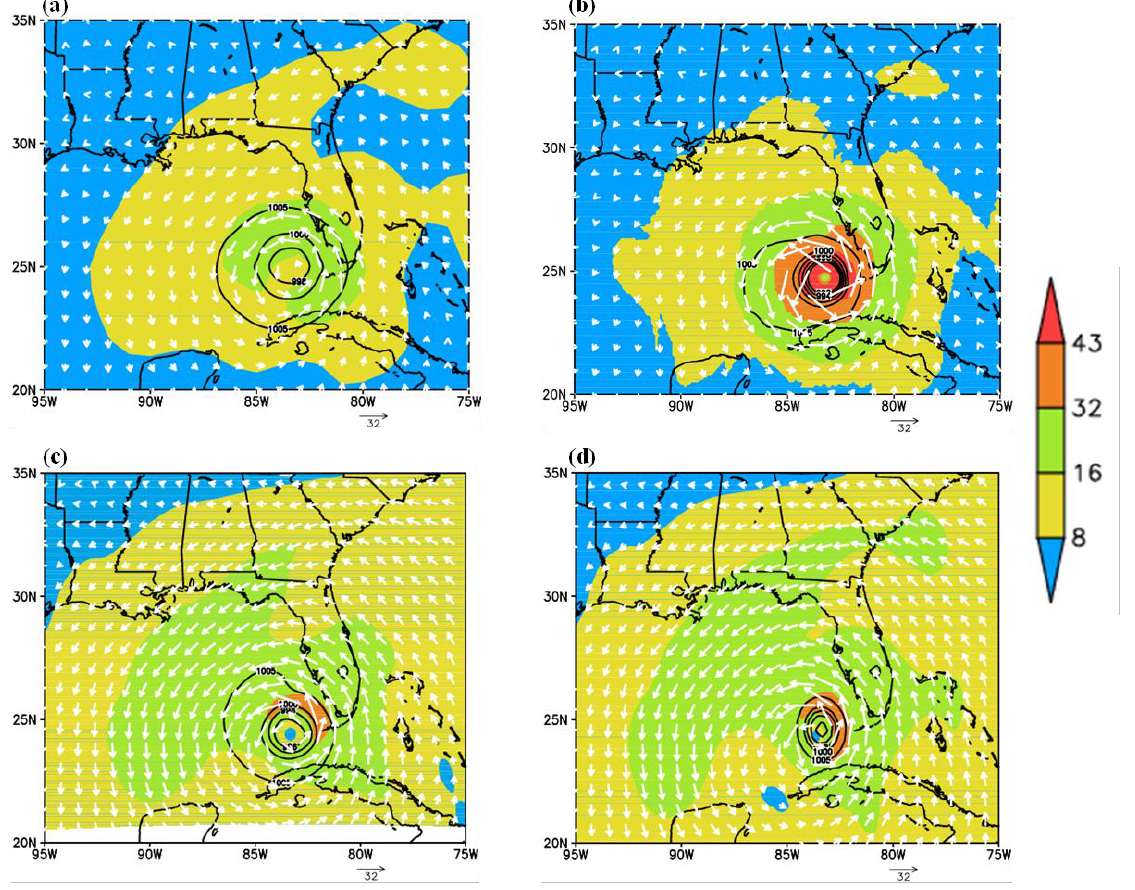
Figure 3. Horizontal distributions of 925 hPa wind speed (m/s) (shaded); sea level pressure (hPa) (contour), and wind vector as white barb associated with the initial vortex at the model initial time of 0000 27 August 2005 with (a) FNL analysis, (b) HWRF model, (c) ARW model, (d) NMM